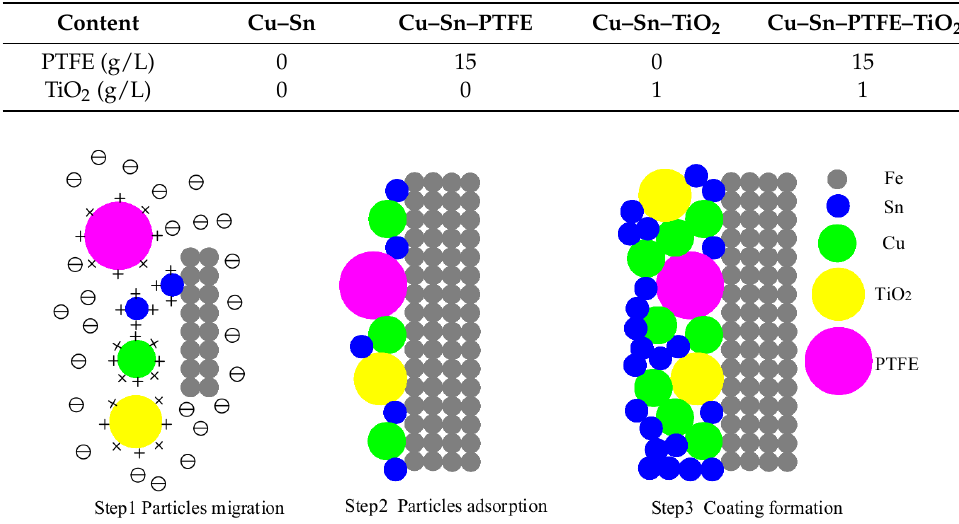
Table 2. The type and quantity of composite particles in each plating solution.